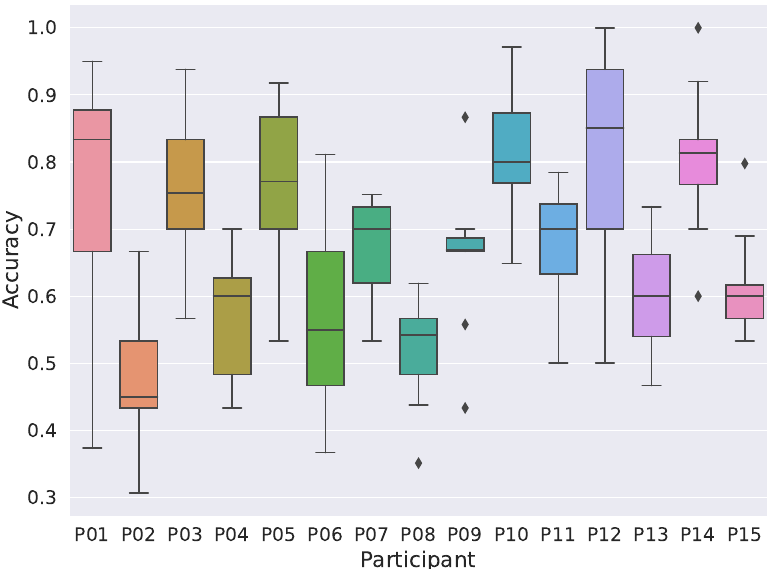
Figure 6. Average cross-validation decoding accuracies for each participant on the full set of